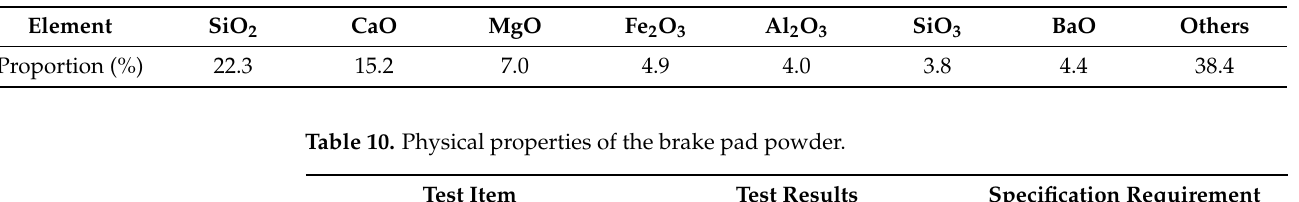
Table 9. Chemical composition of the brake pad powder.